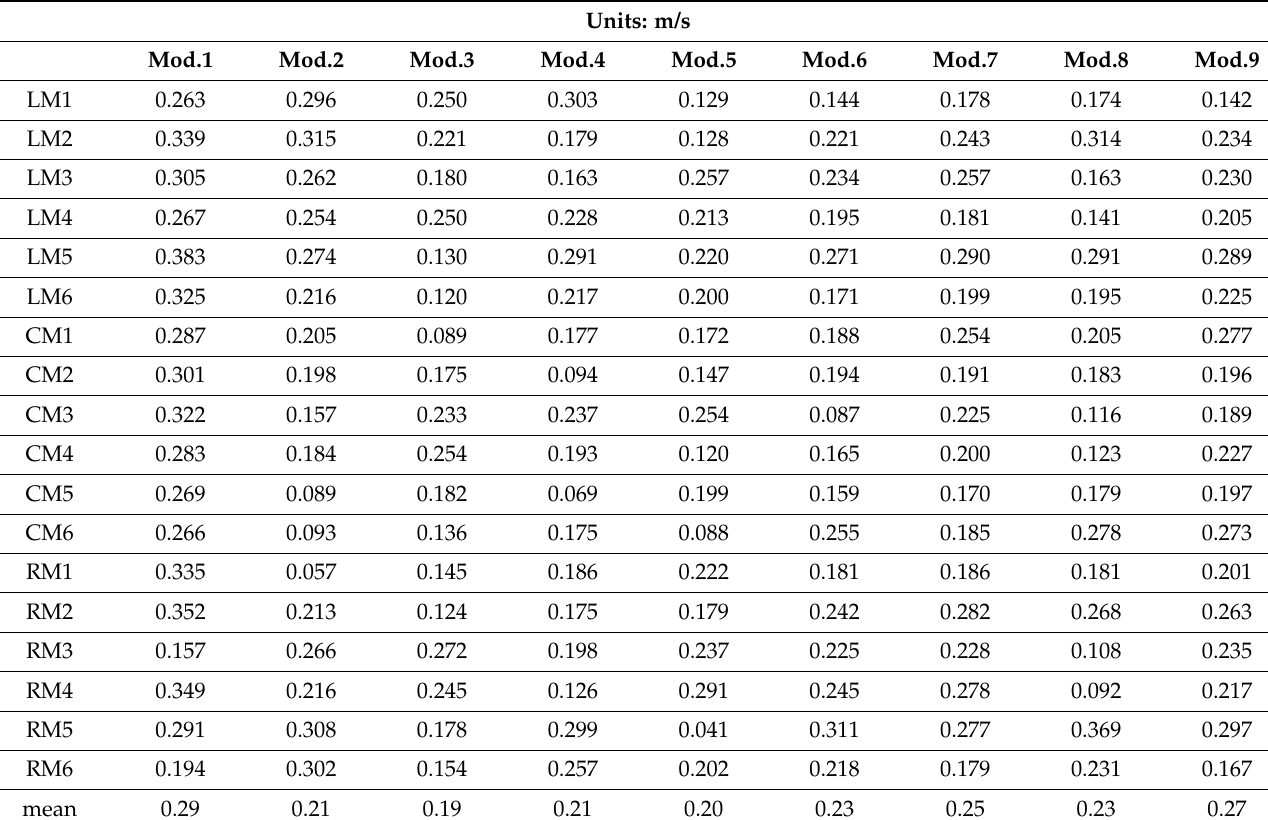
Table 5. Air flow velocity at the central 18 points.